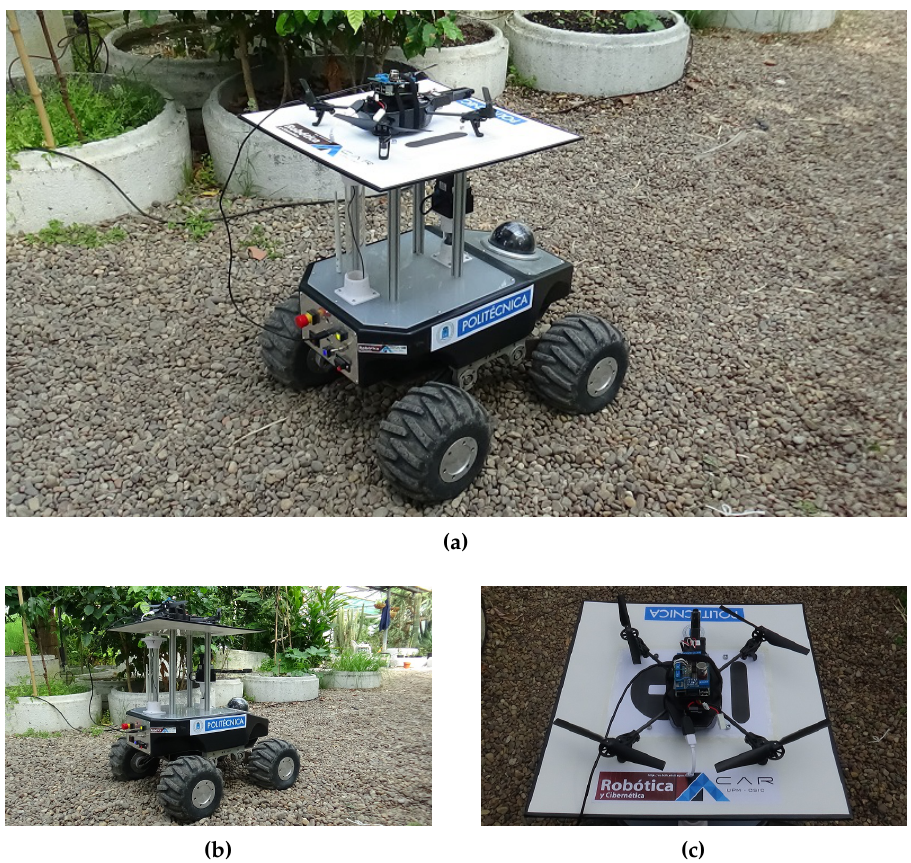
Figure 2. ( a ) Air-ground robot team; ( b ) Ground robot: Robotnik Summit XL; ( c ) Aerial robot: Parrot